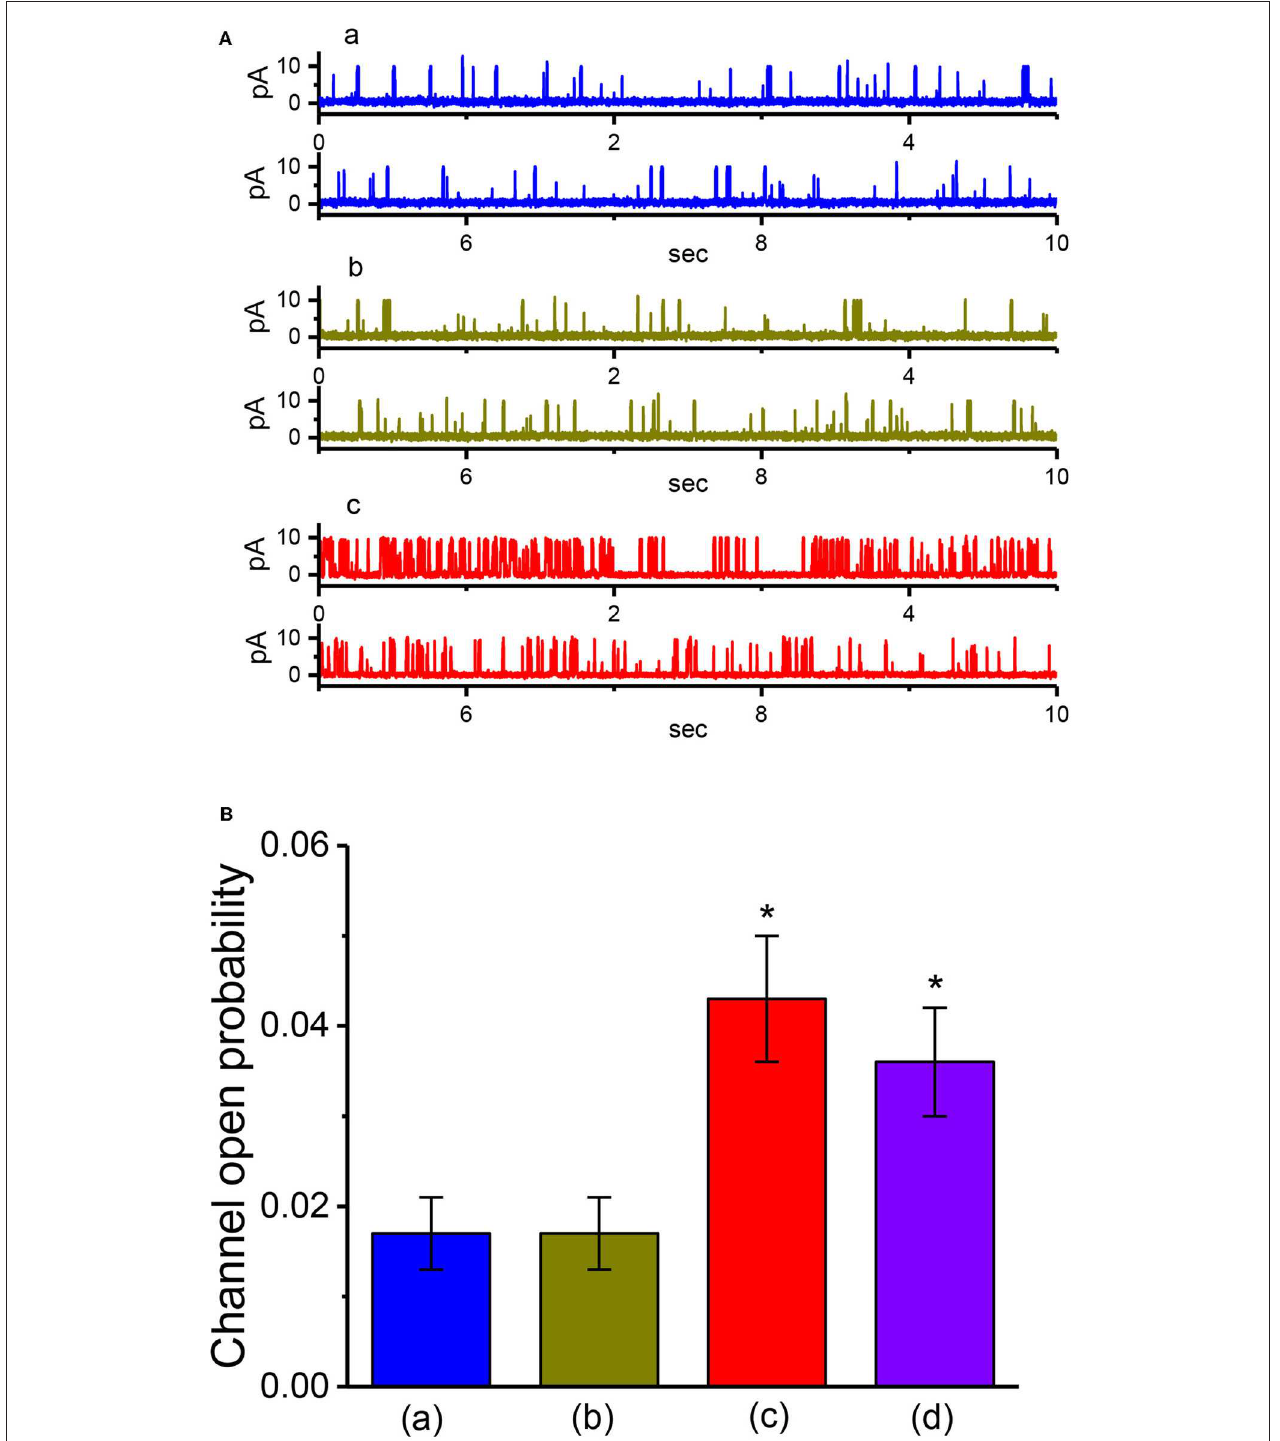
FIGURE 6 | The activity of BK Ca channels produced by VP, VP plus GMQ, or VP plus PF573228 under inside-out current recordings. In these experiments, cells were bathed in high-K + solution which contained 1 µ M Ca 2 + , the excised patch was maintained at + 60mV, and tested compound was applied to the bath. (A) BK Ca -channel current traces measured at + 60mV. a: control; b: 3 µ M VP; c: 3 µ M VP plus 3 µ M GMQ. The open state of the channel is indicated by upward deflection. (B) Summary bar graph showing the effects of VP, VP plus GMQ, or VP plus PF573228 on the probability of BK Ca channels that would be open (mean ± SEM; n = 12 for each bar). *Significantly different from control (i.e., in the absence of any agents; P < 0.05) and **significantly different from VP (3 µ M) alone group ( P < 0.05).